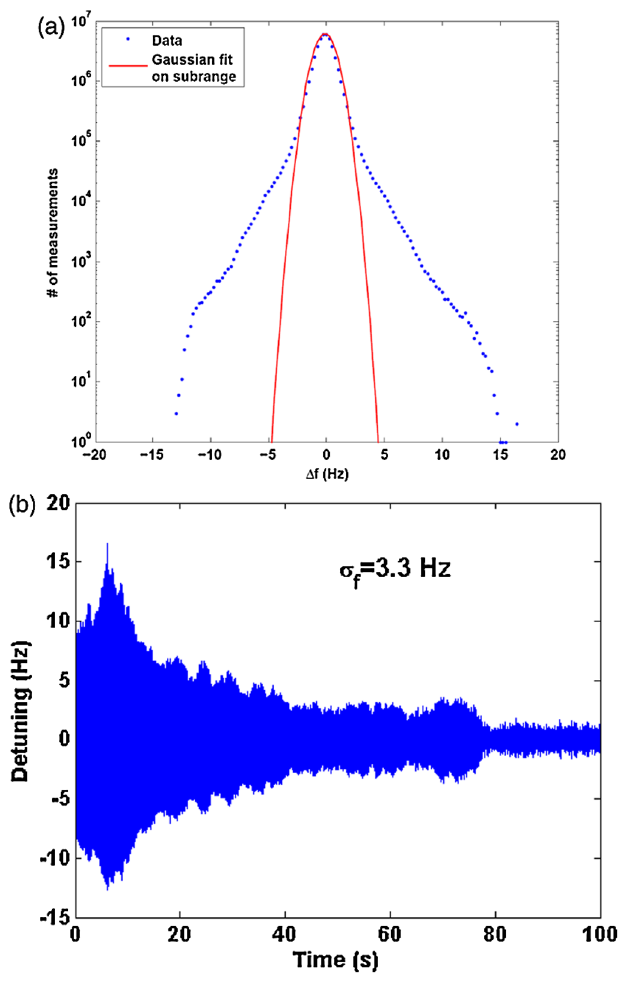
FIG. 6. (Color) (a) Histogram distribution of a long-term micro- phonics measurement over a period of 48 hours. The rms detuning is about 1 Hz. A strongly excited mechanical resonance leads to a peak detuning of 16–17 standard deviations for several tens of seconds on average every 1–2 hours. The time domain detuning signal of the peak event is displayed in